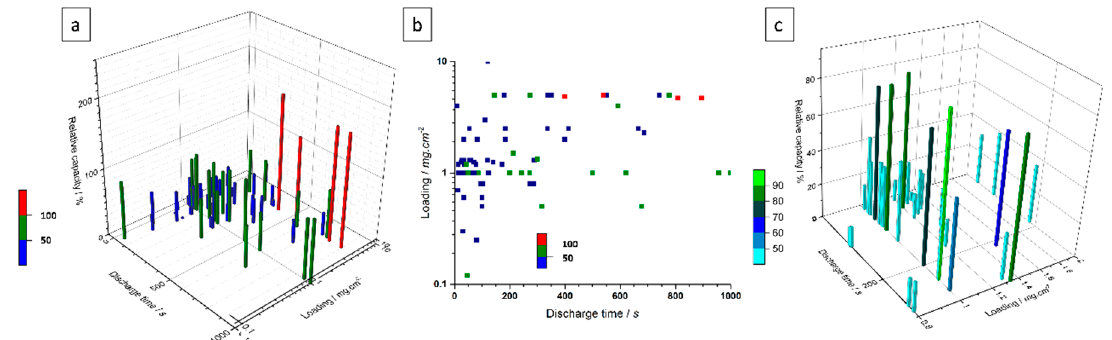
Figure 3. ( a ) 3D histogram of the performance of 42 different materials, showing their relative capacities, their discharge time and their loading; ( b ) Distribution of these materials in a 2D base with discharge time in abscissa and the loading in ordinate; ( c ) Zoom at 1 mg·cm − 2 loading.